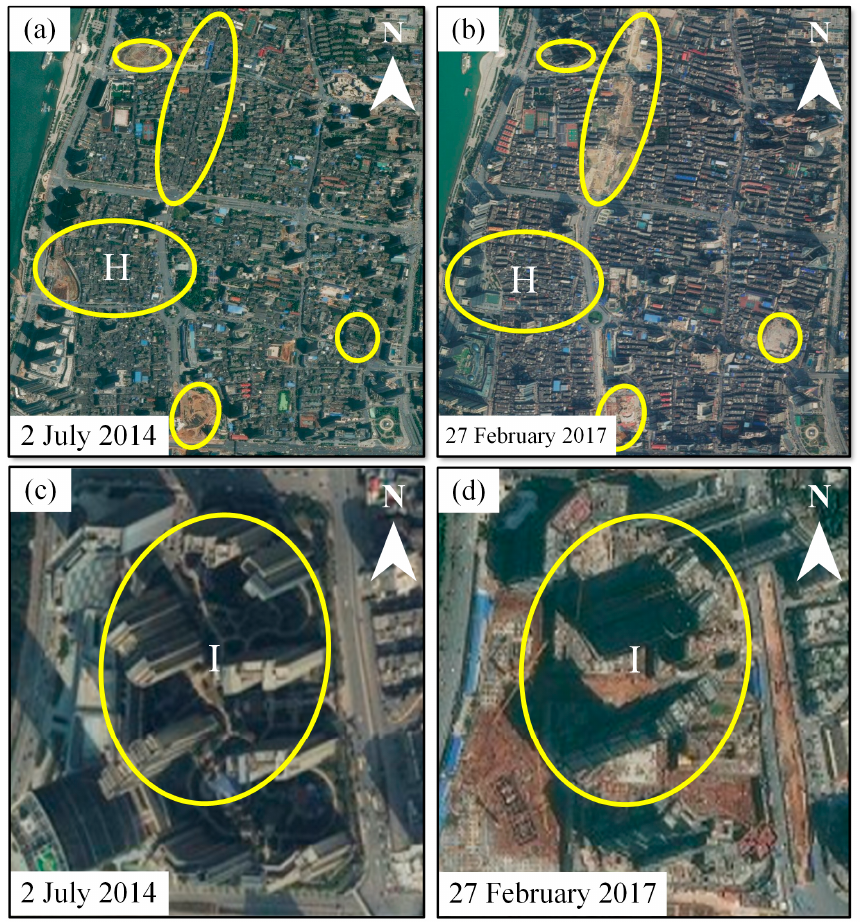
Figure 11. Optical image map of part of the construction area. ( a , b ) Enlarged image of area H. ( c , d ) Enlarged image of area I.